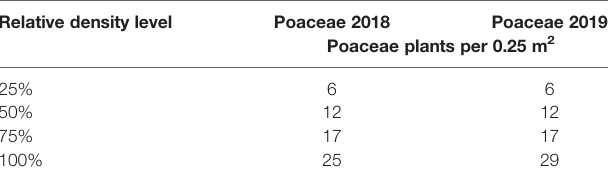
TABLE 1 | Relative density levels as compared to the natural populations of Poaceae plants in 0.25-m 2 quadrats. Relative density level